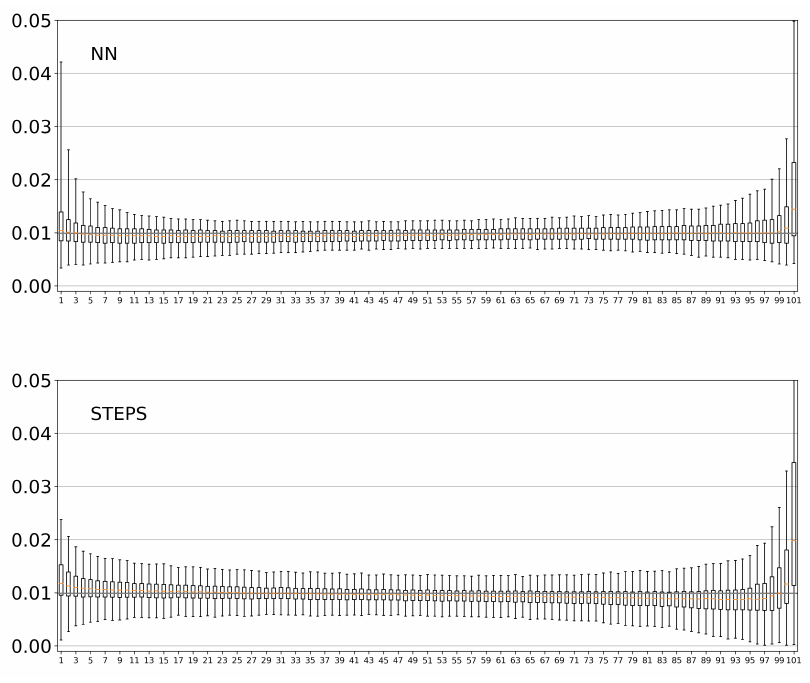
Figures 10 show the cumulative rank histogram for pySTEPS and NN for the prediction 384 of cumulative rainfall in the first hour of forecast. As can be seen both methodologies have Figure 9. Boxplot of the rank histogram for the 100-member ensemble of half-hourly cumulative precipitation forecasts by the NN method and for the STEPS method for all rainfall events in 2017. The reach of the whiskers beyond the first and third quartiles are set to the 5% and 95% percentiles.